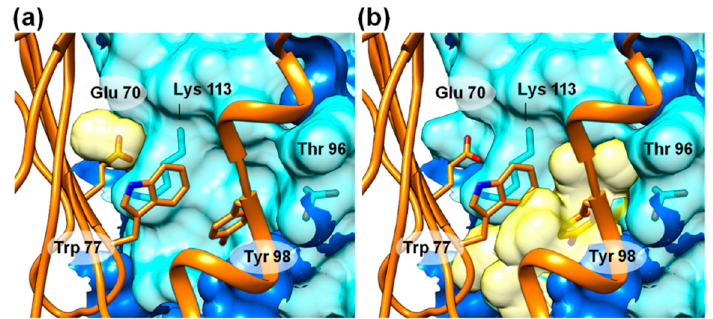
Figure A2. Computed solvent-accessible surfaces between molecules in the S. aureus heterodimer. Sol- vent-accessible surfaces (blue) between RsfS (orange cartoon) and uL14 (cyan surface). Additional sol- vent-accessible surfaces (yellow) that open in S. aureus RsfS mutants: ( a ) E70A and ( b ) Y98A.